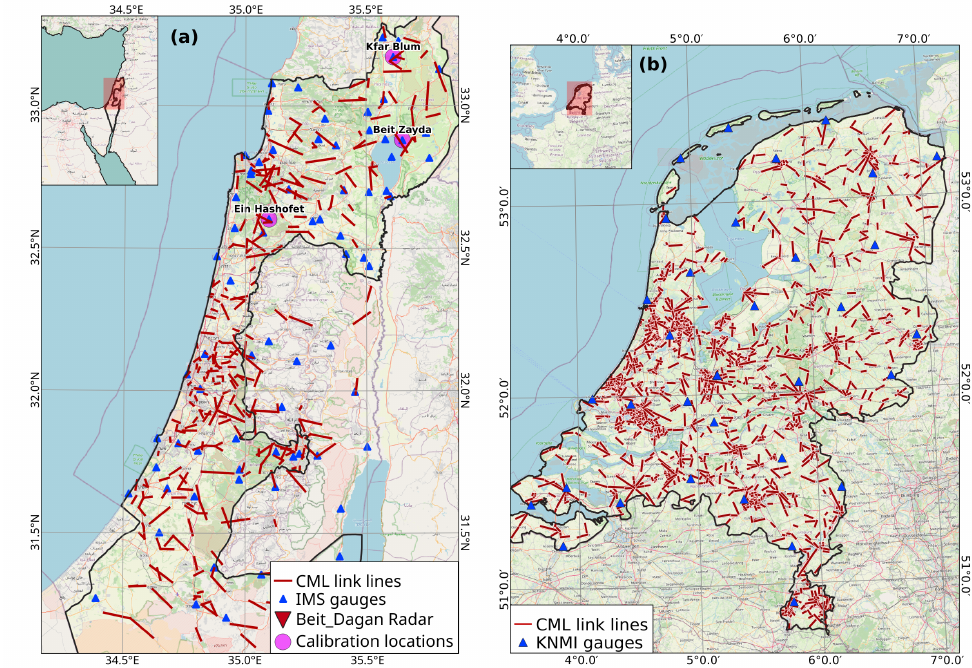
Figure 1. Two study areas ( a , b ) with CML links from cellphone providers and gauge locations. The Israel study area includes calibration locations (Section